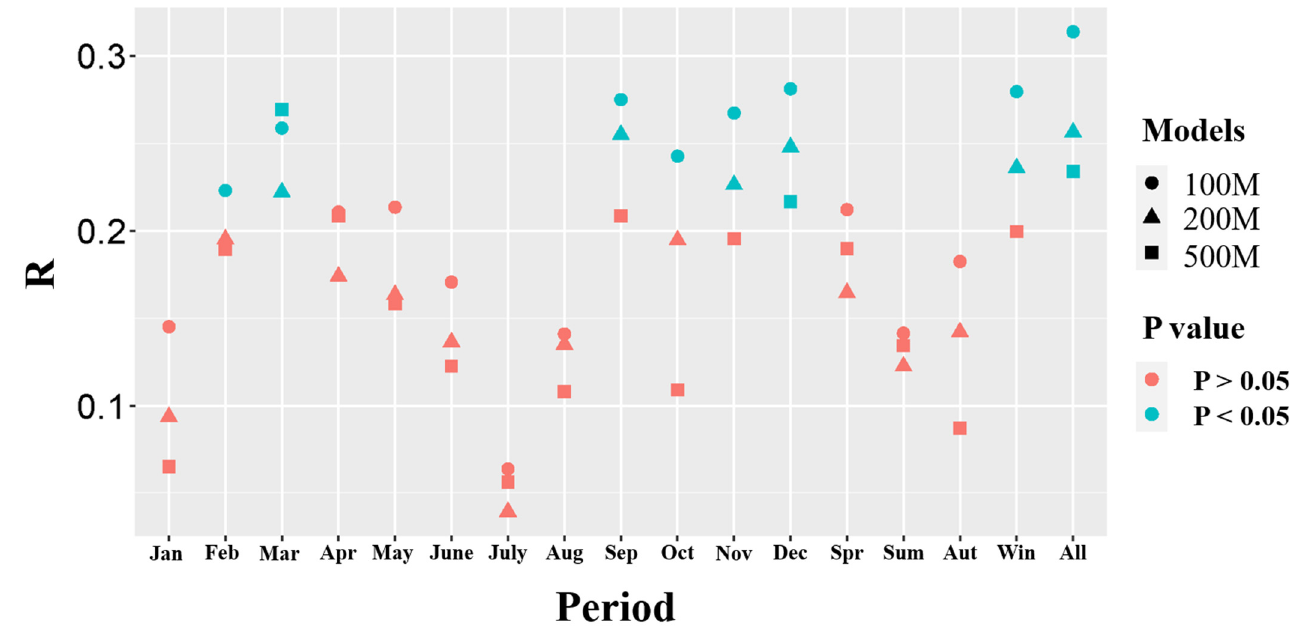
Figure 3. The partial correlation coefficients between PM 2.5 concentrations and PMER by period in 2019.